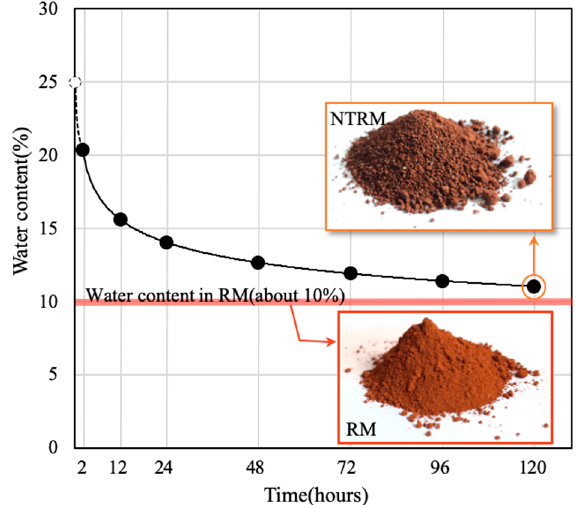
Figure 1. Water content in NTRM with aging time.